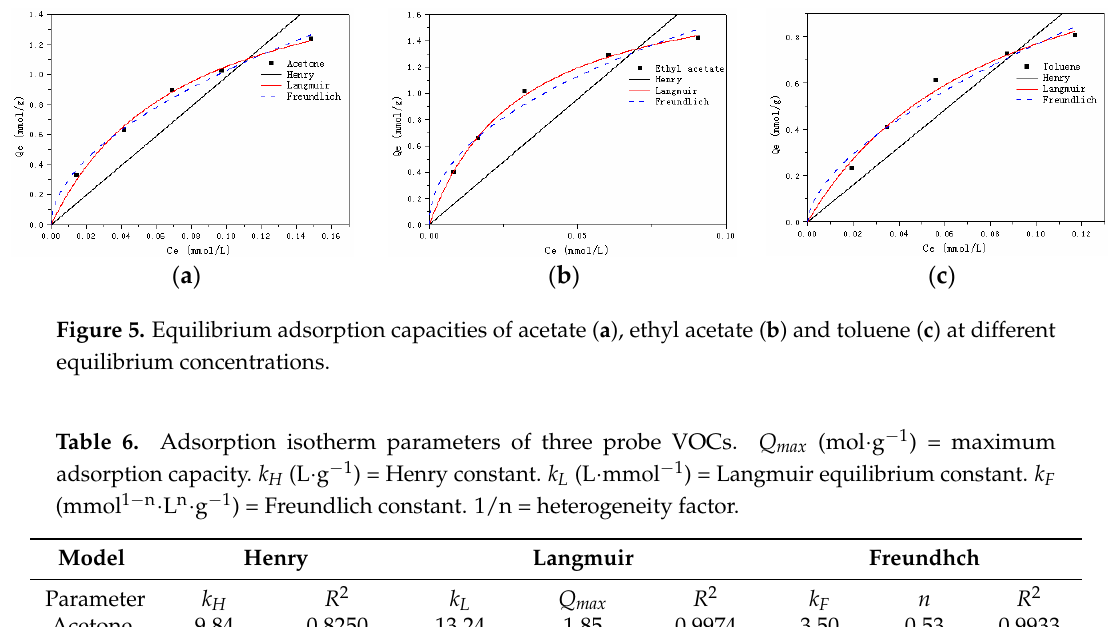
( c ) Figure 4. Kinetic adsorption process of Dt/S-1 (5 wt%) to acetate ( a ), ethyl acetate ( b ) and toluene ( c ). Table 5. Adsorption kinetics parameters of three probe VOCs. Q e = adsorption capacity at equilibrium. k 1 = pseudo first-order rate constant of adsorption. k 2 = pseudo second-order rate constant of adsorption. R 2 = correlation coefficient. Model